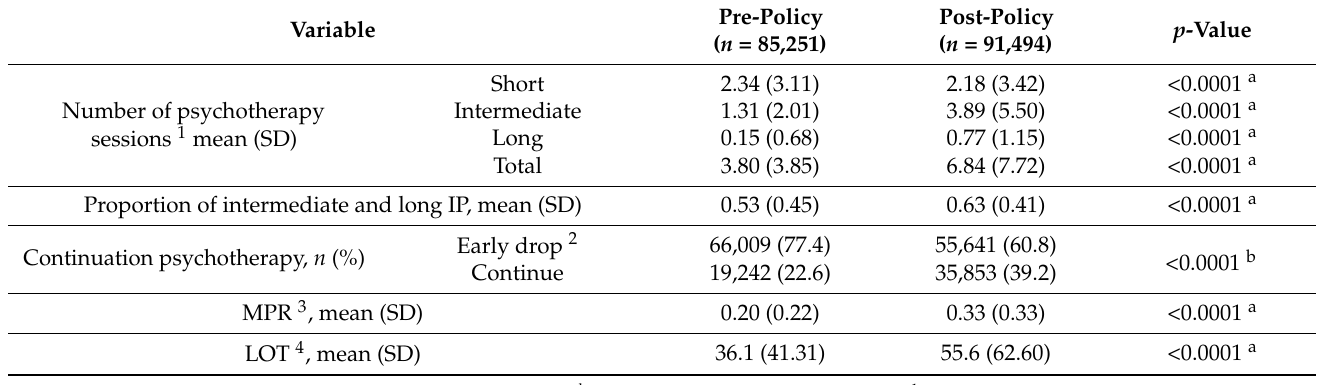
Table A1); 2 Early drop was defined as dropping out after 1–5 session. 3 MPR (medication possession ratio) = sum of days’ supply during the observation period/total observation period (0–1). 4 Length of therapy (LOT)